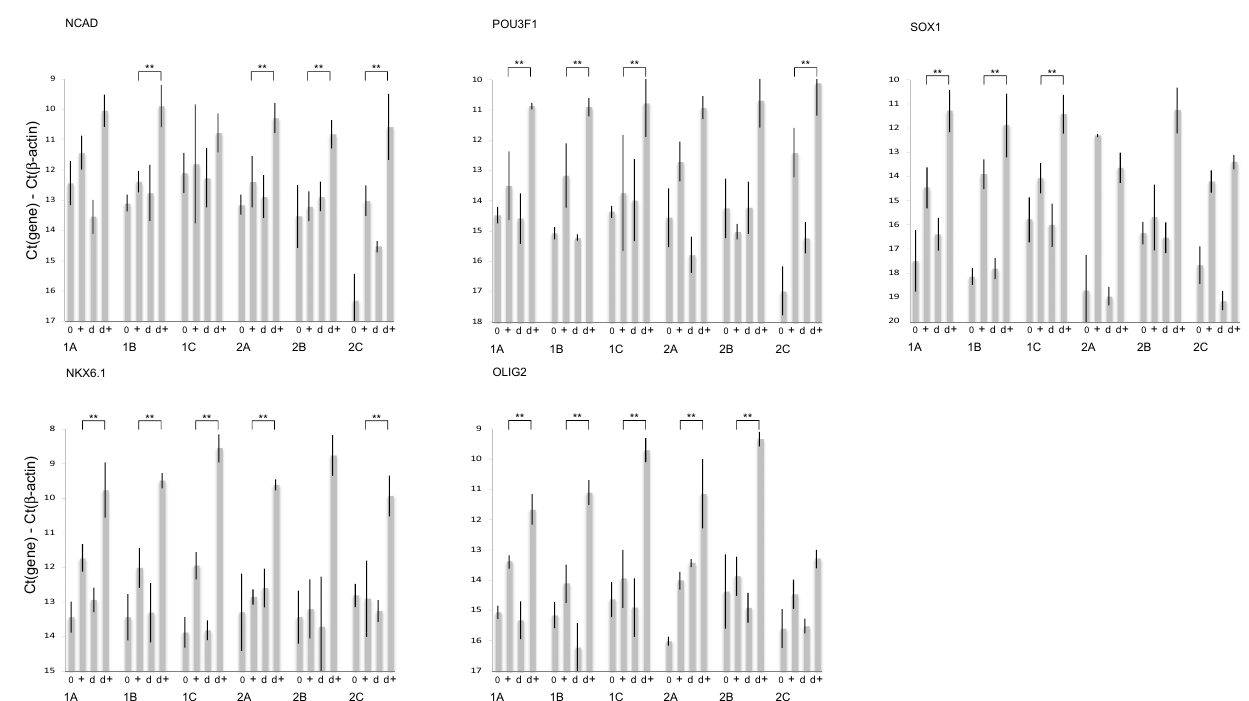
Figure 4. mRNA expression levels for the neural differentiation markers NCAD, POU3F1, SOX1, NKX6.1 and OLIG2 as measured by qPCR. Each grouping of bars represents an iPS clone generated from a 13-year-old marmoset. Groups 1A, 1B and 1C represent three separate clones generated from a single 13-year-old, while groups 2A, 2B and 2C represent three separate clones generated from the other 13-year-old. Labels along the x axis indicate what treatment groups the bar represents. Cells that have not been pretreated with 0.5% DMSO are marked 0 before differentiation and + after the differentiation protocol. Cells that have been pretreated with 0.5% DMSO are marked d before differentiation and d + after the differentiation protocol. A double asterisk indicates that the cells in this group, when differentiated after pretreatment with DMSO, display significantly increased marker expression ( p < 0 . 05 one-way ANOVA followed by Dunnett’s test) when compared with their same clone controls that were not pretreated with DMSO. Each directed differentiation was replicated three times per clone and averaged: n =